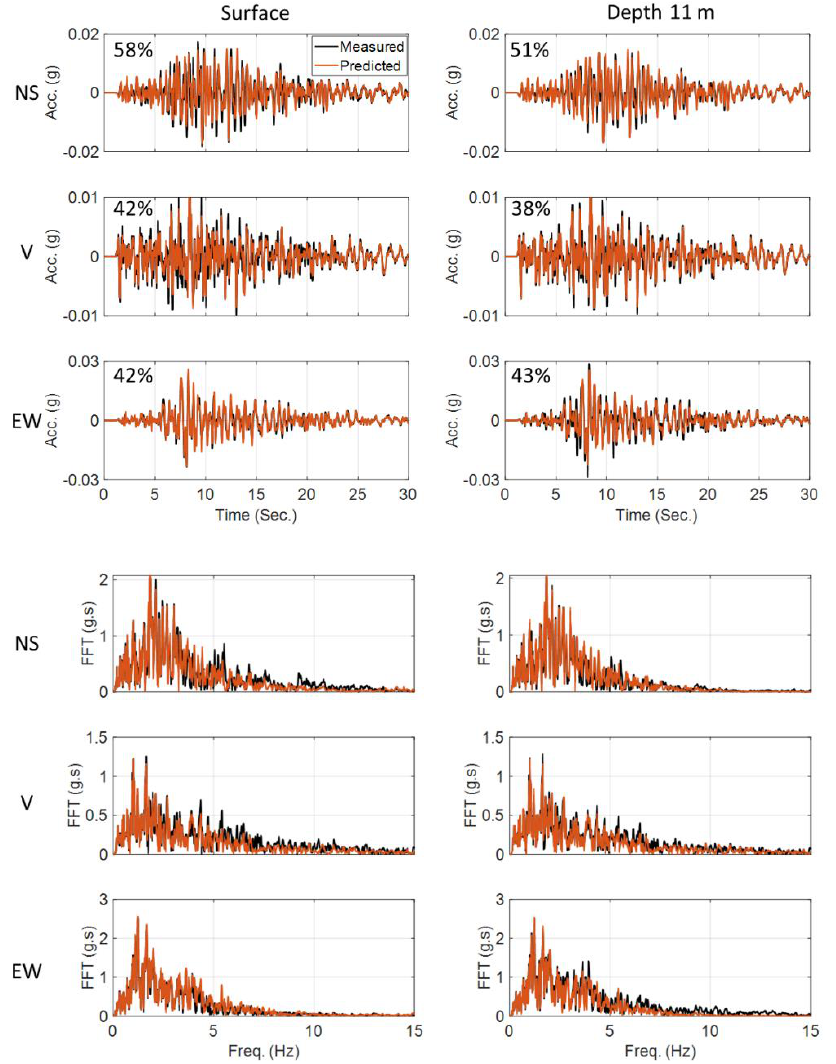
Figure 21. Time- and frequency-domain comparison between the recorded and estimated acceleration responses for the South Napa 2014 earthquake.